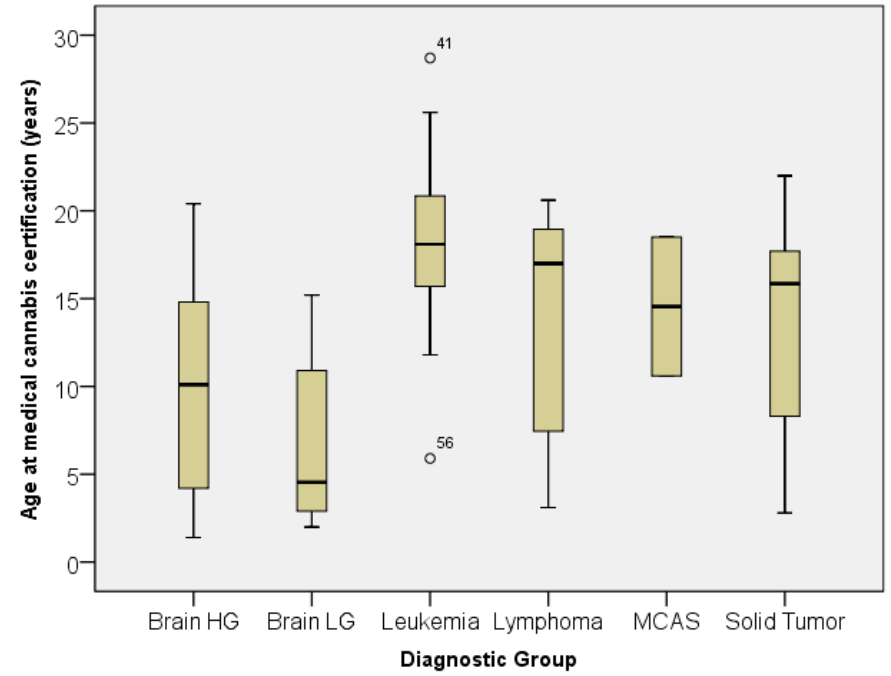
Figure 3. Medical cannabis dispensed by diagnostic group.